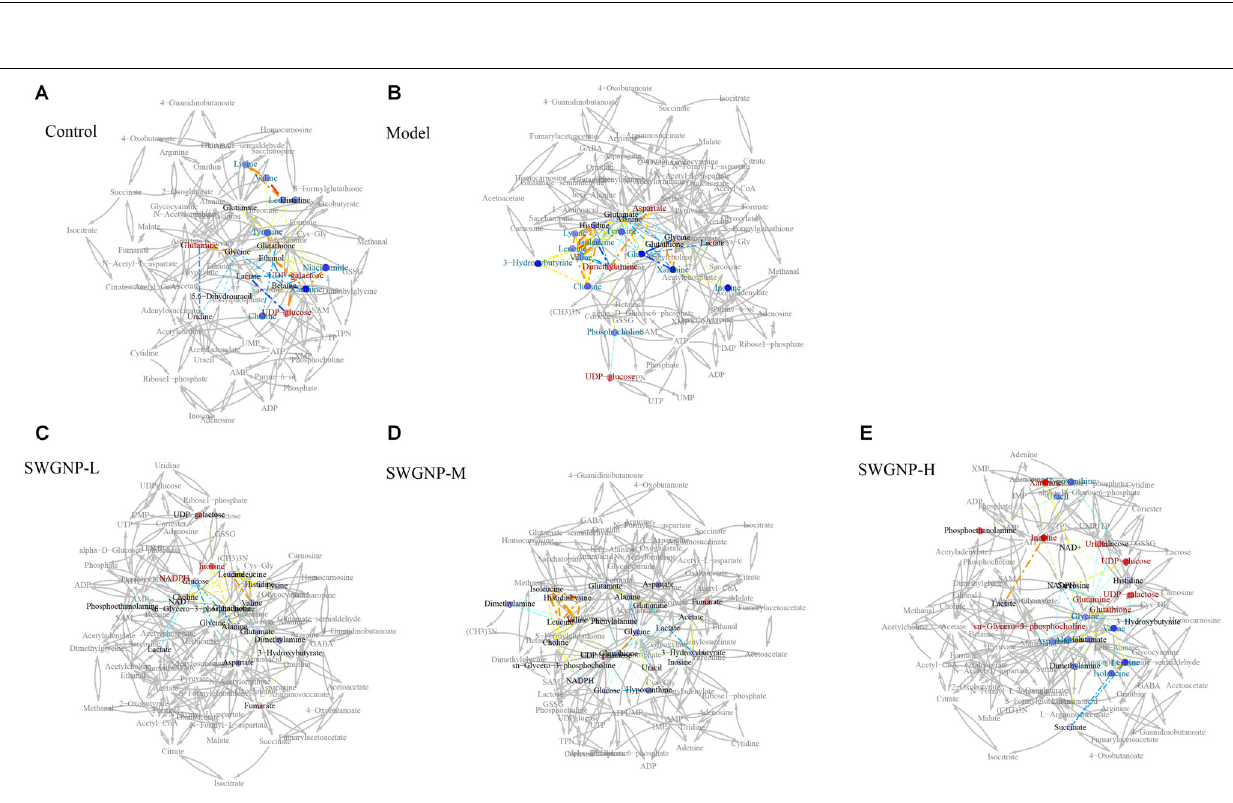
Frontiers in Pharmacology |